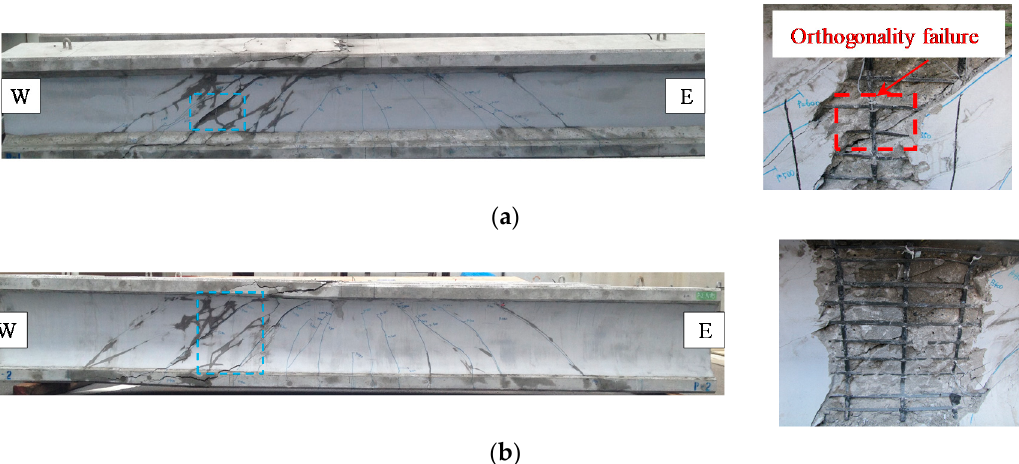
Figure 6. Crack patterns of strengthened beams: ( a ) RWC5; ( b ) RHWC5. The pictures on the right correspond to the marked areas (blue dashed rectangle) on the specimens, showing the grid.